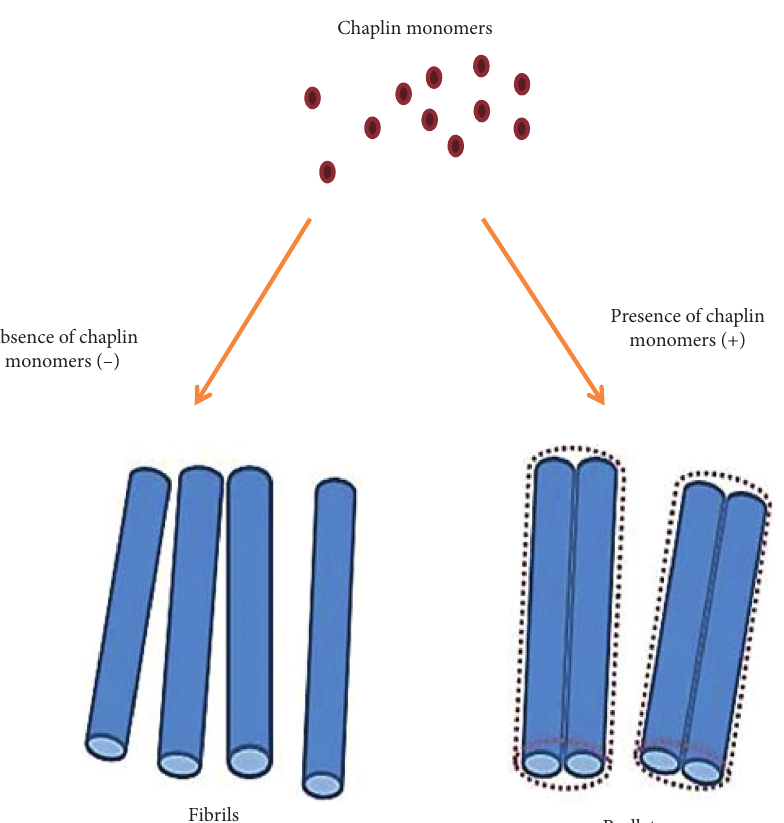
Figure 3: The rodlet layer formed in Streptomyces coelicolor strain; it is a result of the assembly of two types of proteins—chaplins and rodlins. In the absence of rodlins, the aggregation of chaplins provides fibrils. This illustration reproduced from Petrus and Claessen’s research